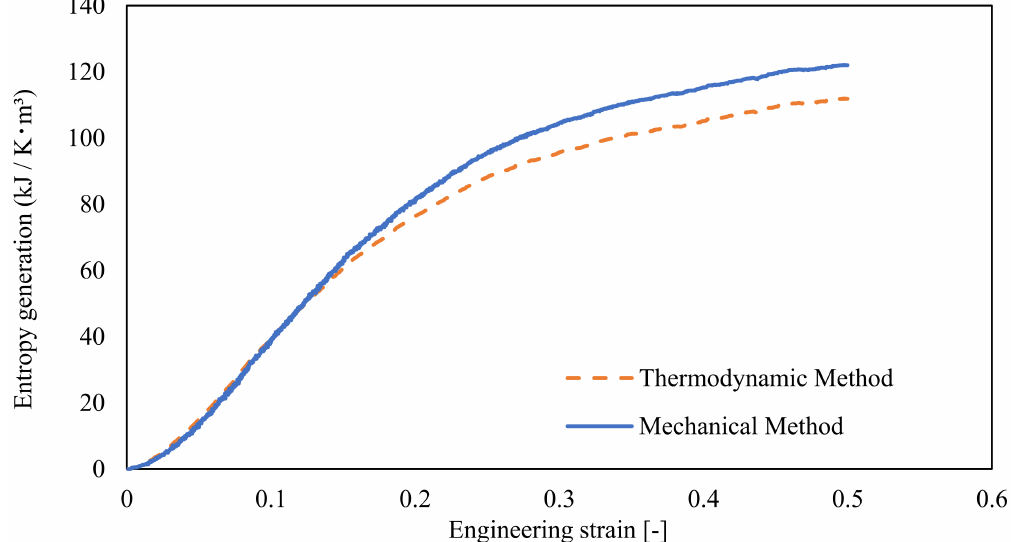
Figure 3. Fracture and thermal entropy generation of PA6 during tensile analysis using MD simula- tions.